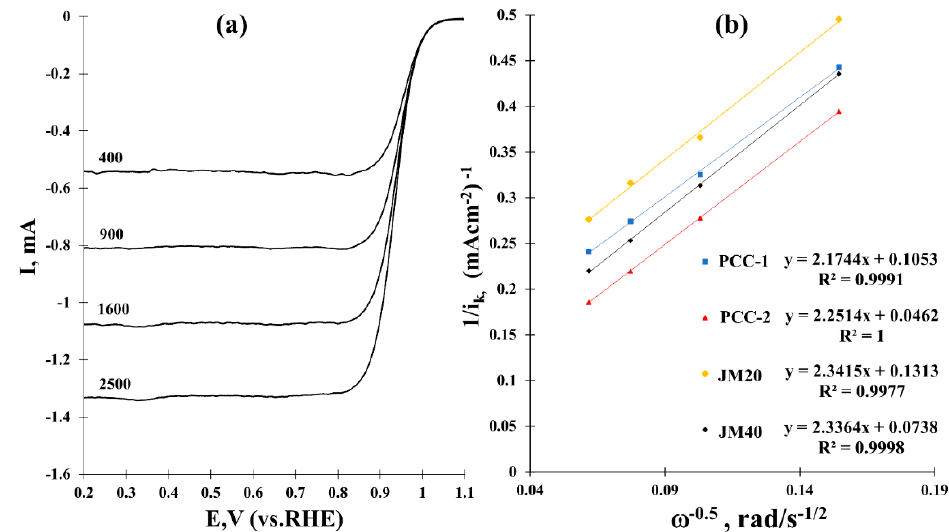
Figure 8. LSV curve for ORR at different rotation speeds ( a ) and the corresponding dependences 1/ I k vs. ω − 1/2 at potential of 0.90 V. ( b ) Rotation speed 400, 900, 1600, 2500 rpm, potential sweep rate is 20 mVs − 1 . Electrolyte—0.1 M HClO 4 solution saturated with O 2 .